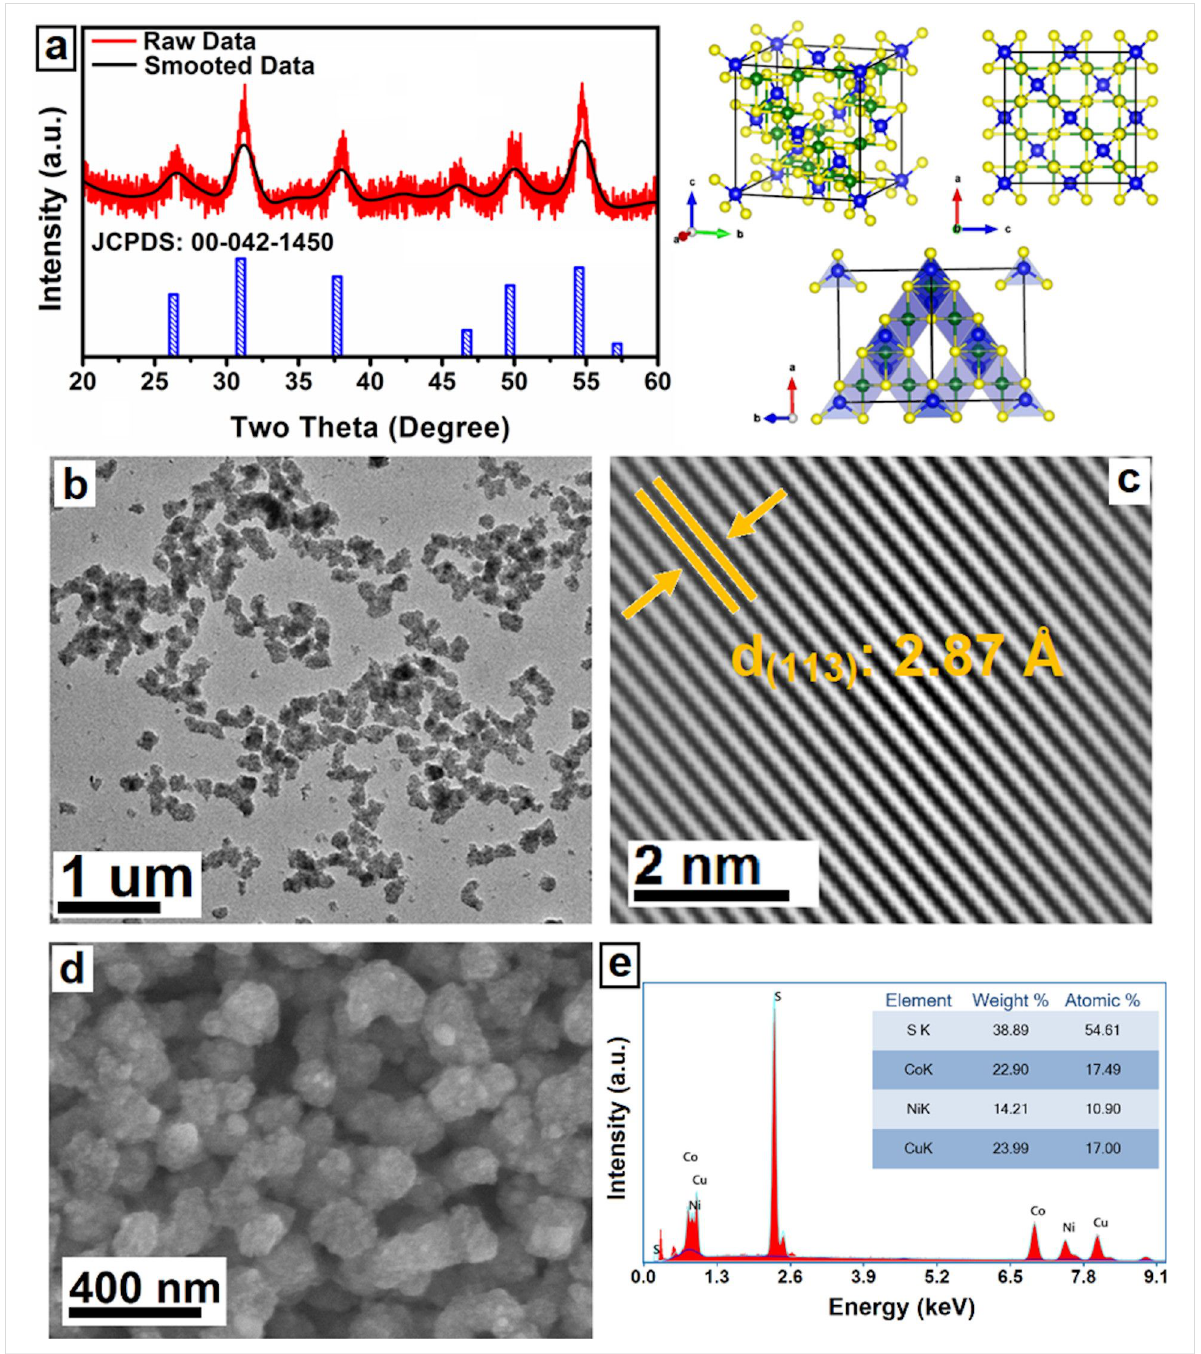
Figure 2: (a) XRD pattern and crystal structure model, (b) TEM image, (c) HR-TEM interplanar spacing image, (d) FE-SEM image and (e) EDS pattern of the CuNiCoS 4 nanocrystals.